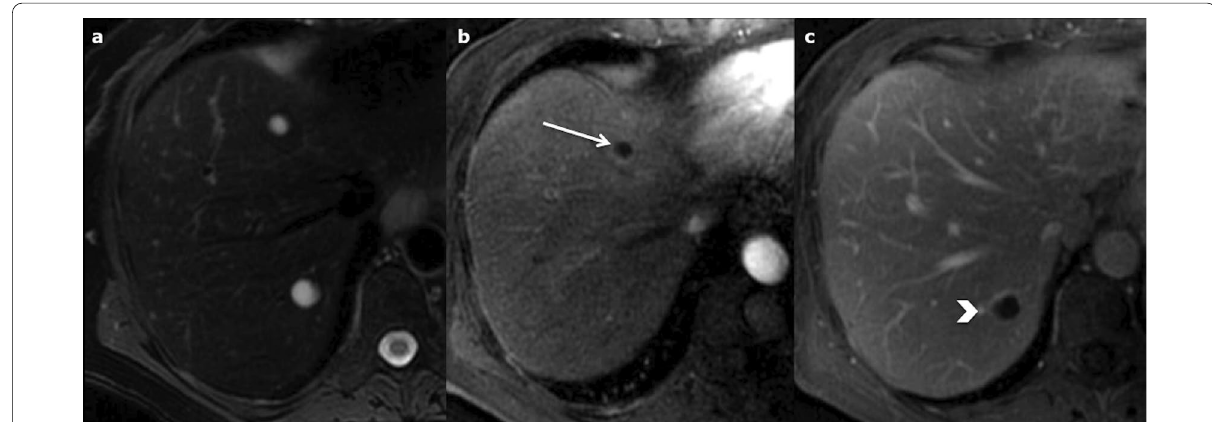
Fig. 25 Cystic metastasis of a mucinous tumour of the rectum in a 72-year-old male. The hyperintensity on axial T2-weighted magnetic resonance imaging a is marked but the multiple tiny septa (arrows) incompletely enhanced on portal venous phase ( b ) are sufficient to reach a conclusive diagnosis in this the